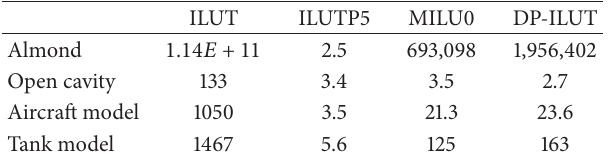
Table 2: Condest , of different preconditioned linear systems equa- tion (12) for 3D scattering example.